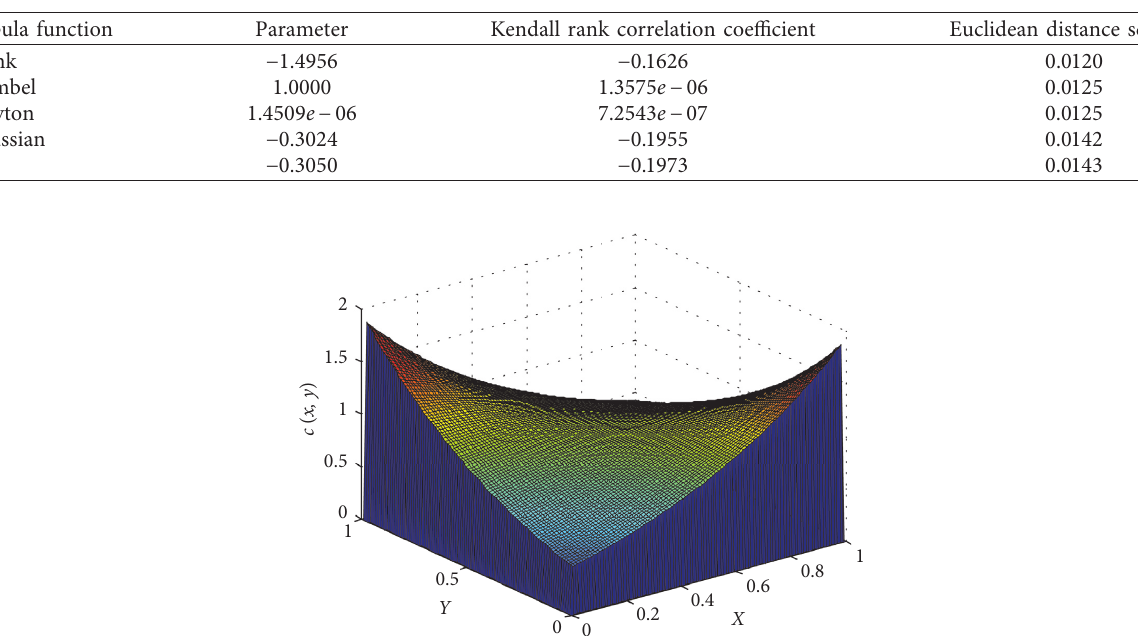
Figure 1: Empirical Copula function. Table 3: Estimation results of the optimal Copula function.